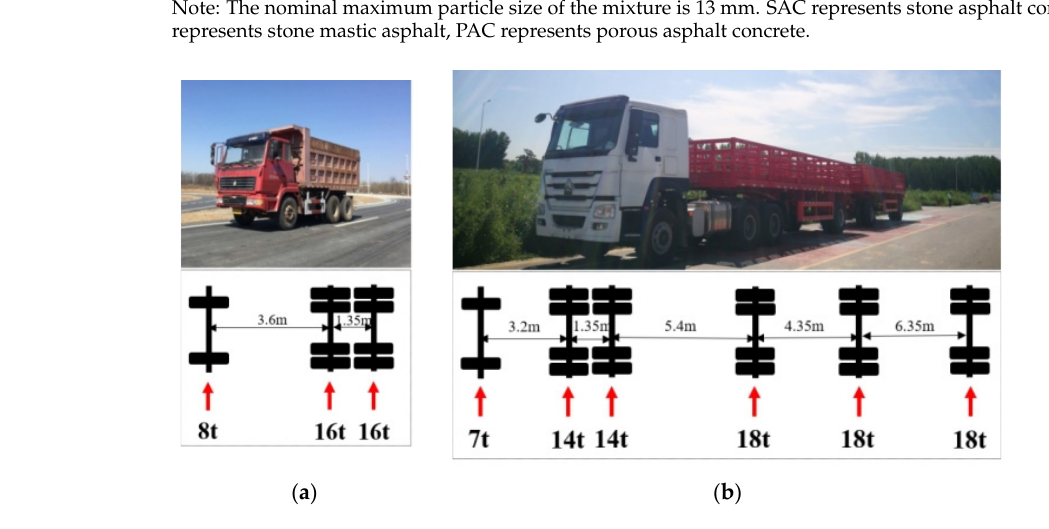
Figure 1. Loading modes of RIOHTrack. ( a ) Loading mode-A. ( b ) Loading mode-B.